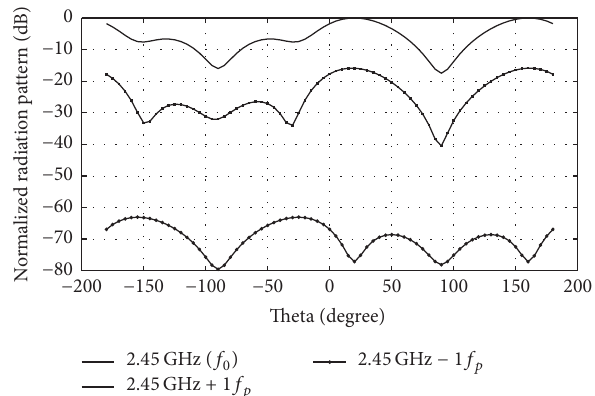
Figure 8: Radiation pattern at centre frequency 2.45 Ghz and sidebands.